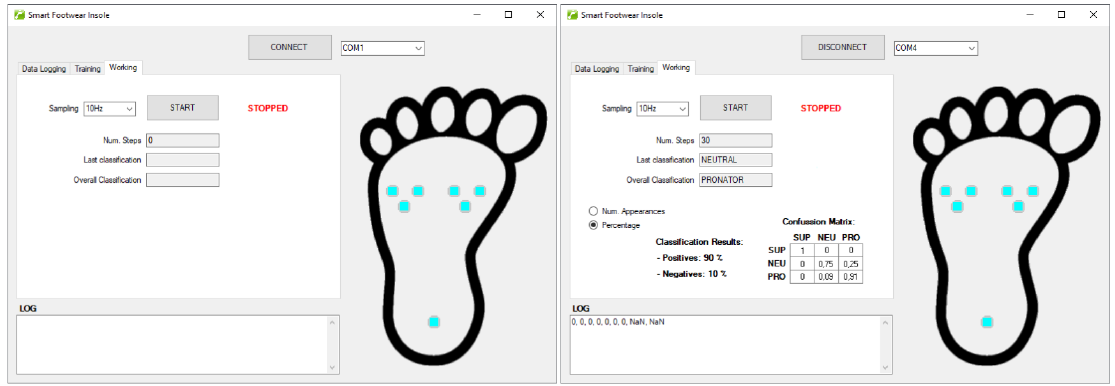
Figure 8. User Application 2: ( left ) Classification, ( right )